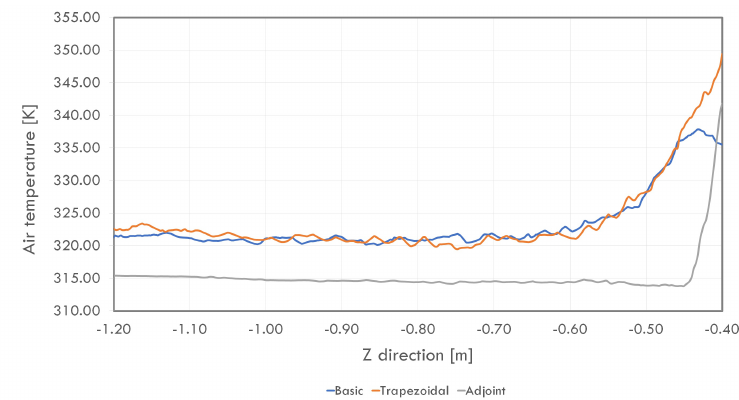
Figure 29. Comparison of the temperature dependence behind the heat